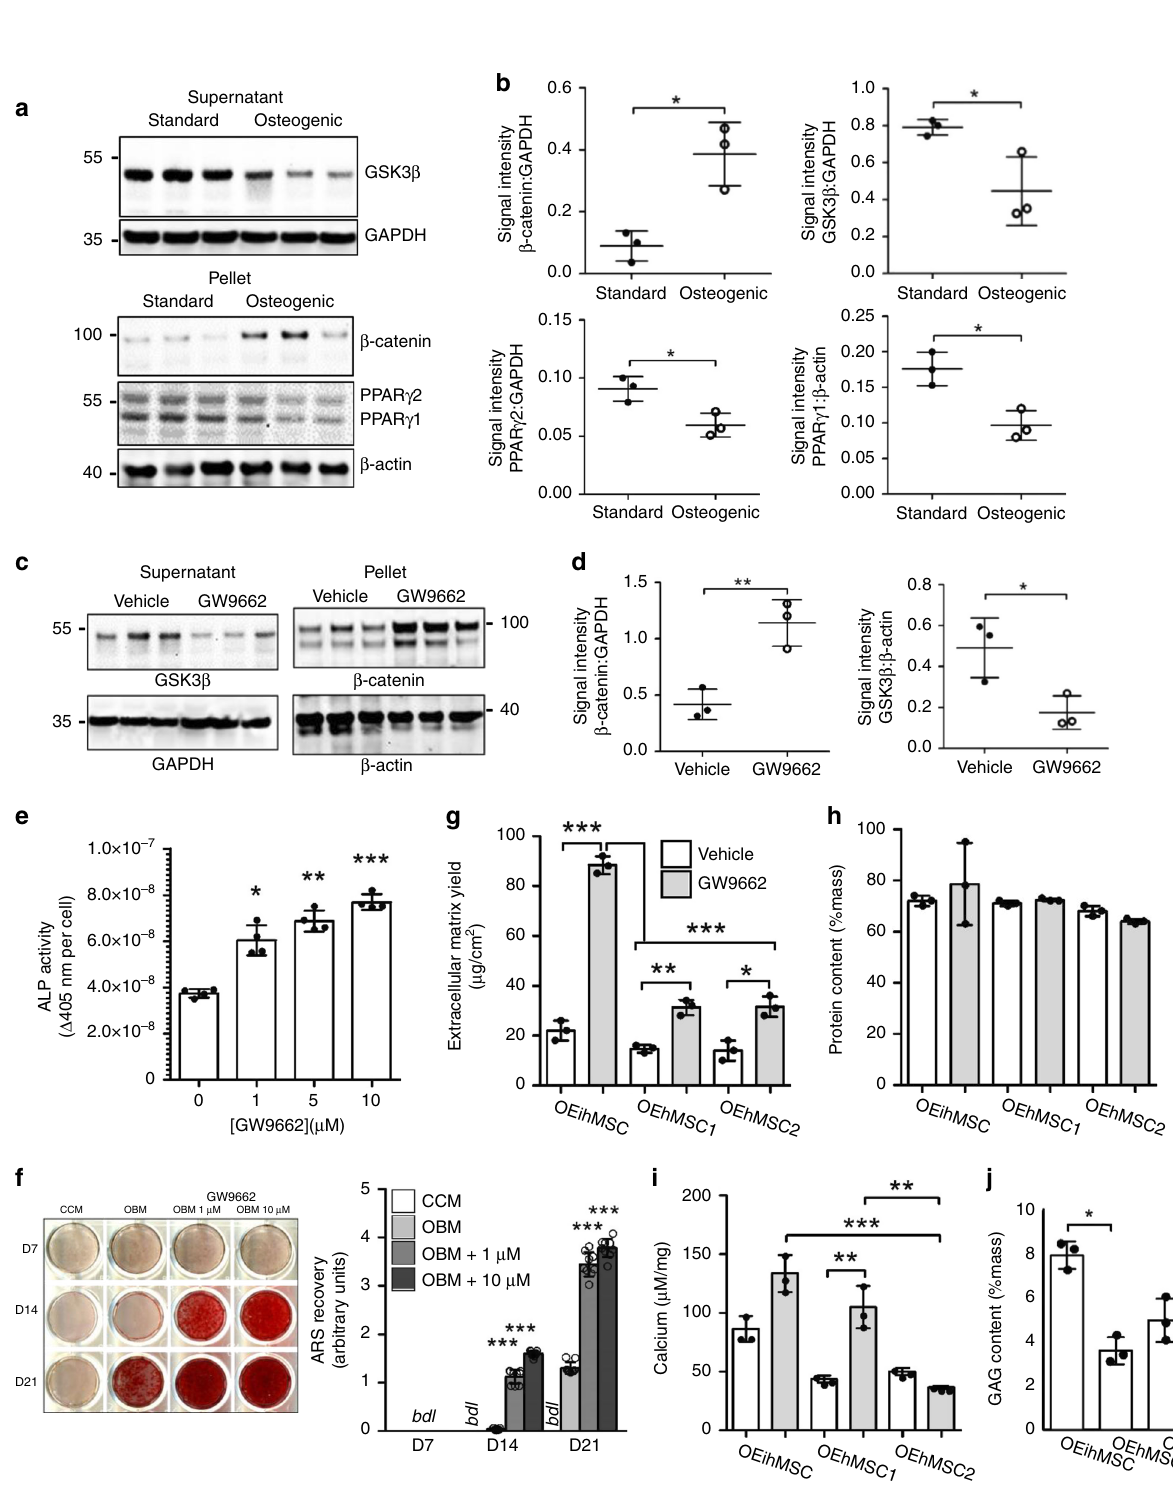
Fig. 1 ihMSCs share many of the key characteristics of BM-hMSCs. a Fold recovery in 7 days after plating at 500 cells per cm 2 after 3 – 9 passages. b Average doubling time for cultures in a . c Cumulative cell yield in 120 days. The red dashed line represents the initial rate of expansion. d Immunophenotype of ihMSCs. e ihMSCs differentiate into osteoblasts and chondrocytes but less so to adipocytes in standard assays. Bar = 100 μ m for monolayers and 25 μ m for chondrogenic assays. Each image is a representative of six images taken from three separate experiments. Controls presented in Supplementary Fig. 3a. f Heat map summarizing fold-change transcription of differentiation biomarkers. The scale represents z -score, raw data presented in Supplementary Fig. 2b. g ARS quanti fi cation assay comparing ihMSCs mineralization to two BM-hMSC preparations. h As g , but performed in the absence of dexamethasone. Statistics: panels a , b , g , h presented as means with SD, compared using one-way ANOVA with Tukey ʼ s or Dunnett ʼ s post-test. * p < 0.05, ** p <0.01, *** p <0.005. For panels a – c , f , n = 6, for panels i and j , n = 4. Source data are provided as a Source Data fi